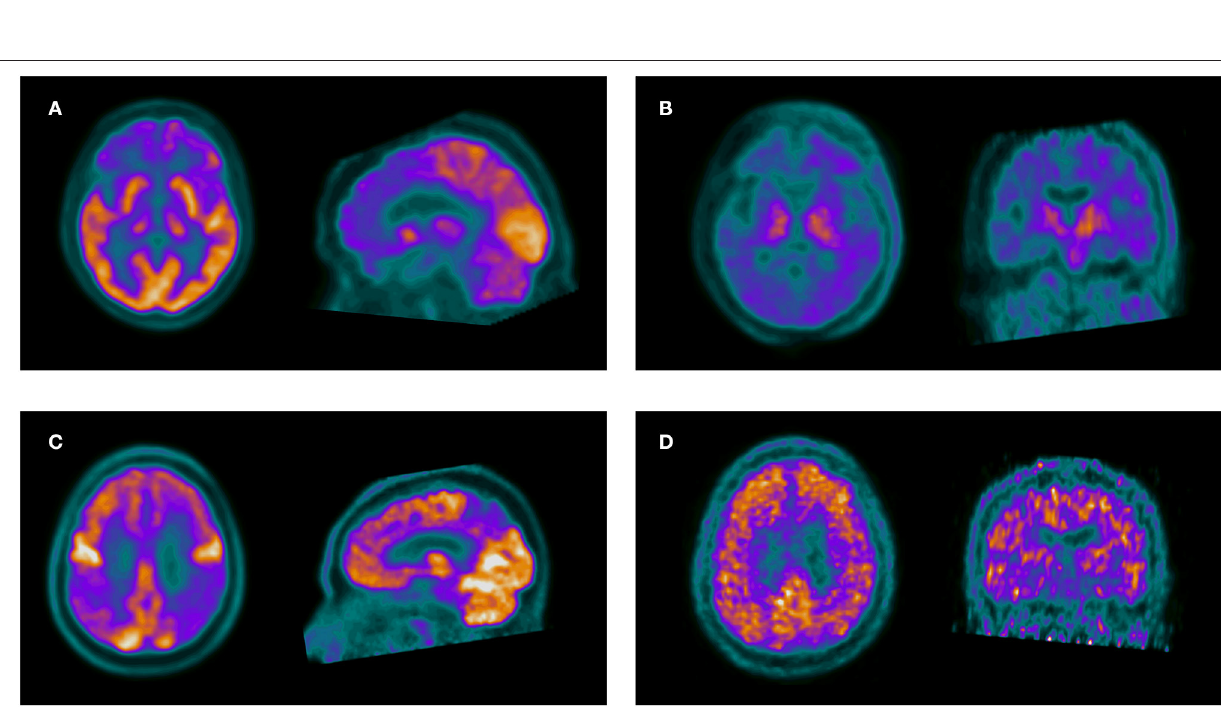
Frontiers in Neurology | www.frontiersin.org